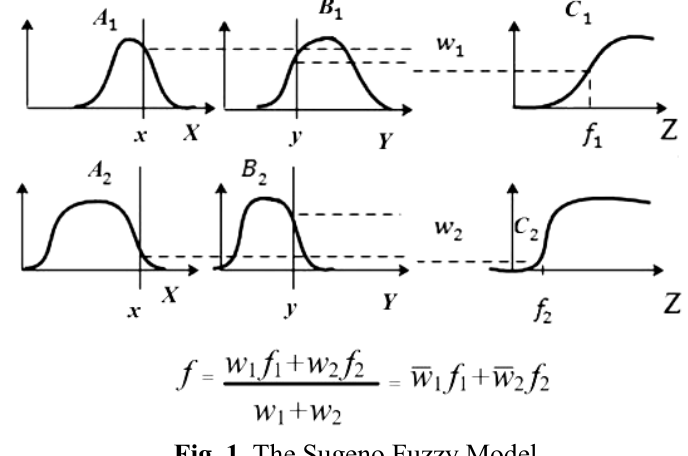
Fig. 1. The Sugeno Fuzzy Model.